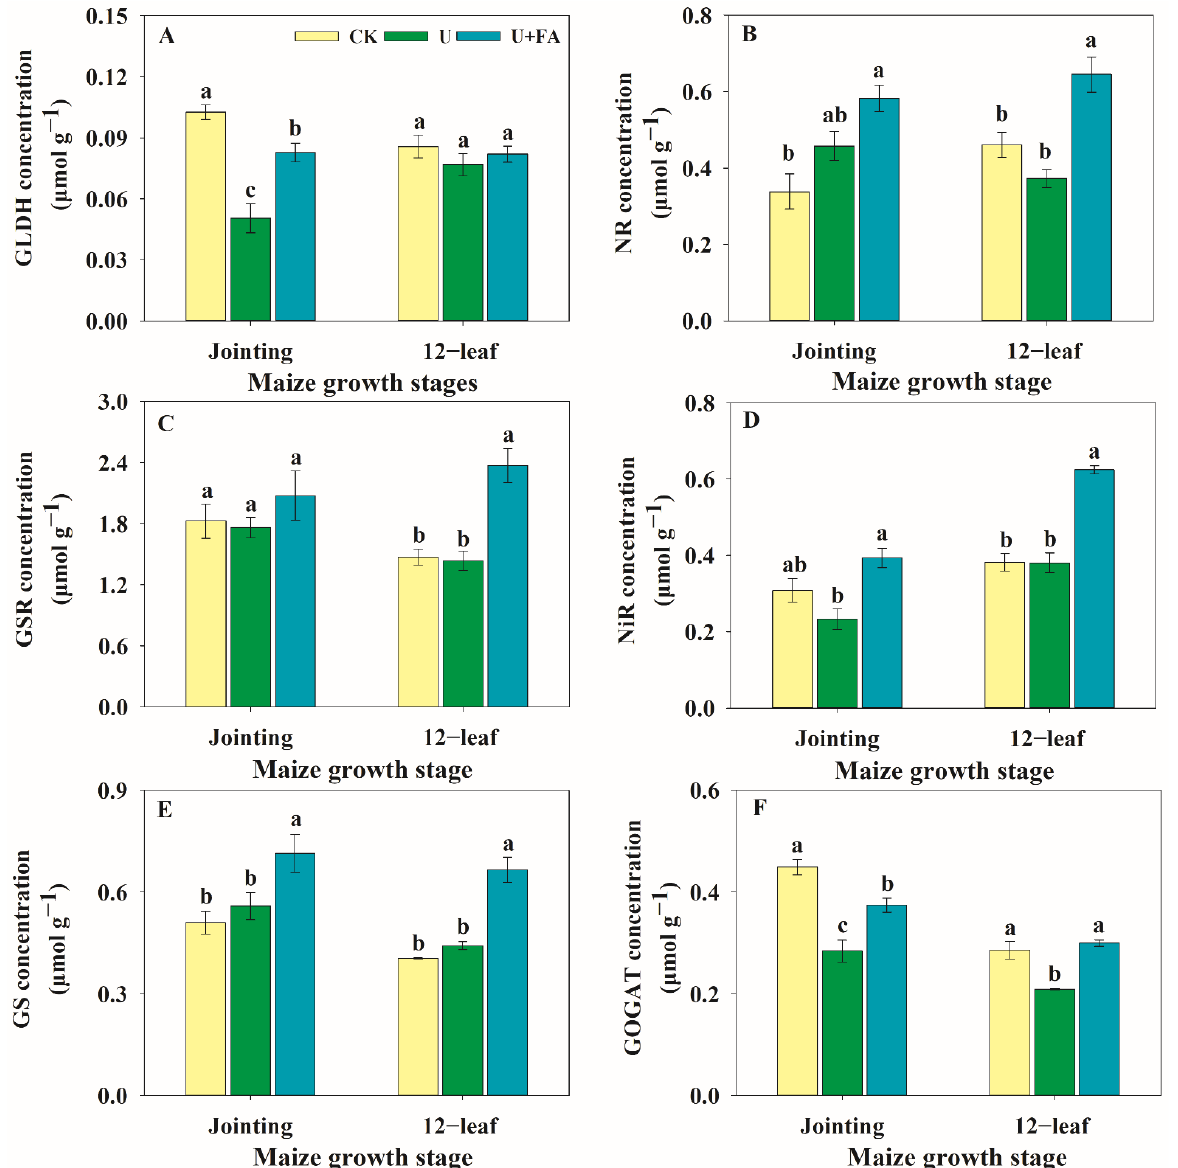
Figure 5. Effects of different fertilization treatments on the concentrations of N metabolism-related enzymes of glutamate dehydrogenase (GLDH, ( A )), nitrate reductase (NR, ( B )), glutathione reductase (GSR, ( C )), nitrite reductase (NiR, ( D )), glutamine synthetase (GS, ( E )), and glutamate synthase (GOGAT, ( F )) in maize leave at the jointing and V12 stages, in 2018. The treatments include: no nitrogen fertilizer (CK); application of urea (U); combined application of urea and fulvic acid solution (U+FA). The values are means of four replicates, and the error bars are standard errors. Different letters indicate significant differences between treatments for a same growth stage according to SNK’s test at p < 0.05.